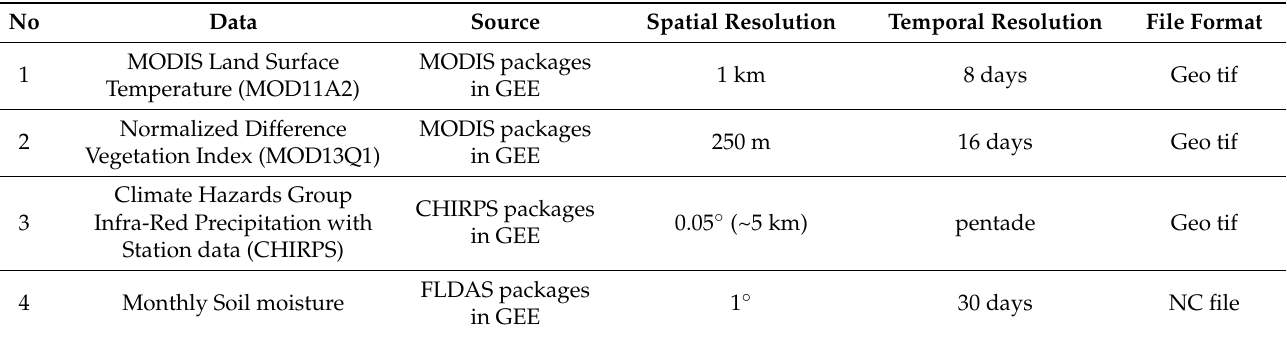
Table 1. Remote sensing data used in this study.